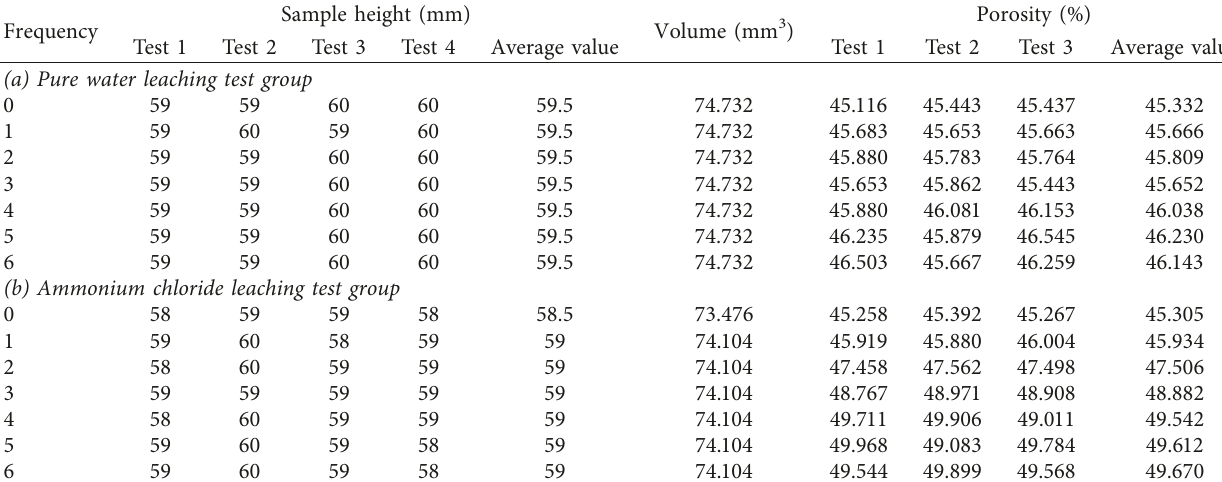
Table 3: Physical parameters and porosity distributions of the